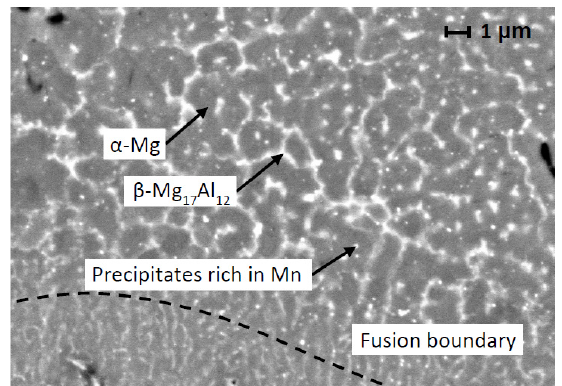
13 of 16 Figure 12. Sample 7-1: ( a ) longitudinal-L section; ( b ) transverse-T section. For a detailed assessment of the microstructure, an analysis using a scanning electron microscope (SEM) was carried out. Figure 13 shows the very fine microstructure of the